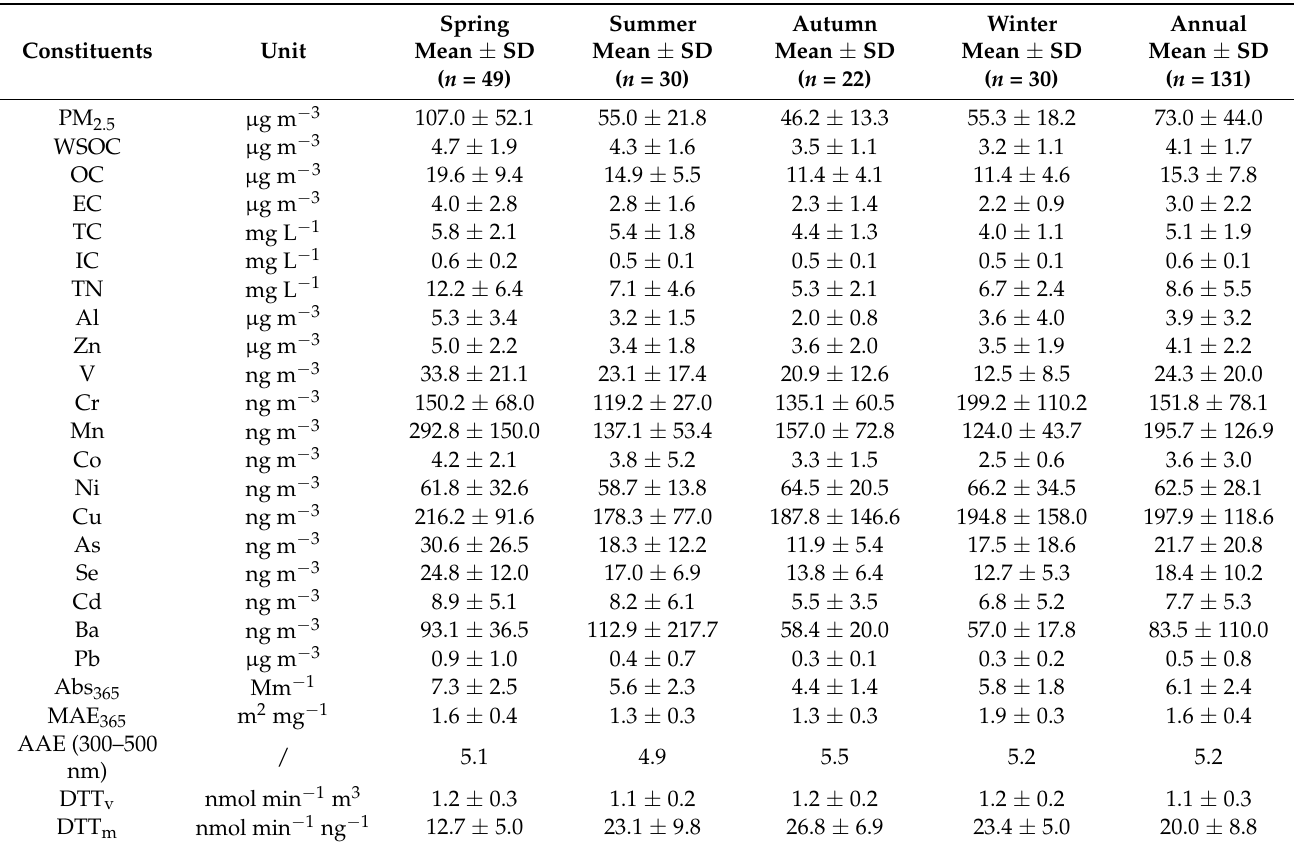
Table A1. The WSOC, OC, EC, TC, IC, metals, Abs 365 , MAE 365 , AAE, DTT v , DTT m , and PM 2.5 mass concentrations in all